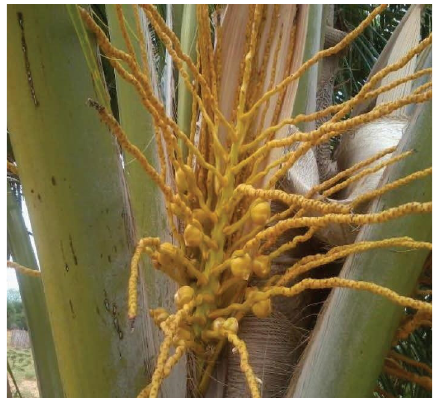
Figure 1: Coconut inforescence.